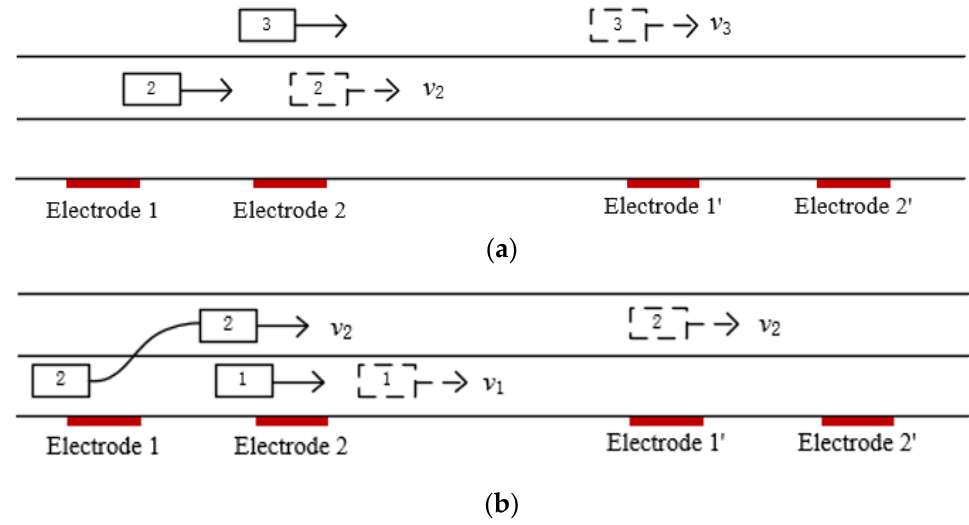
Figure 17. Diagram of two groups of electrodes for two scenarios: ( a ) two vehicles driving in differ- ent lanes; ( b ) changing lanes and overtaking.